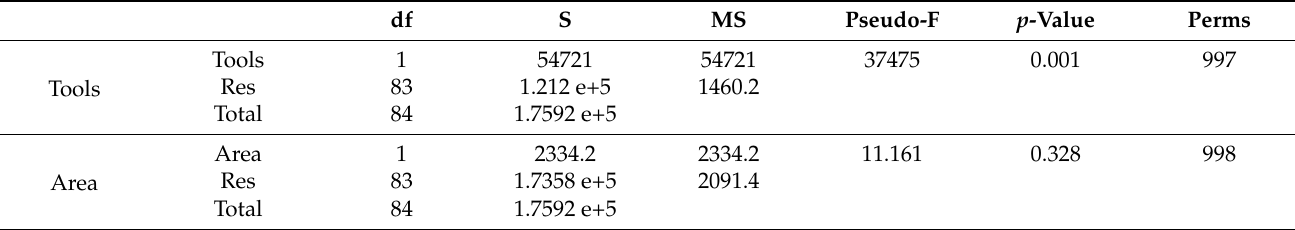
Table 5. Results of similarity percentages analysis (SIMPER) of the differences in species composition between areas and sampling tools.